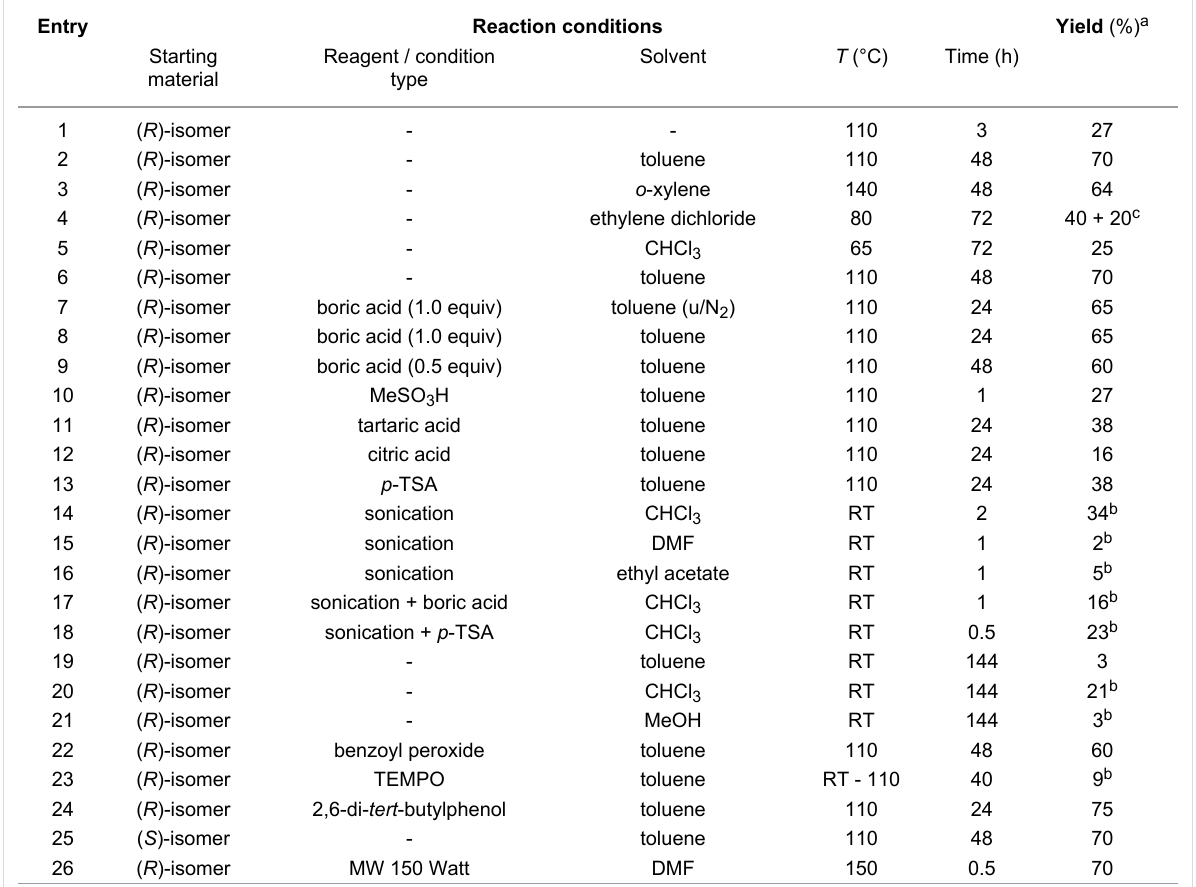
Table 1: Screening of rearrangement